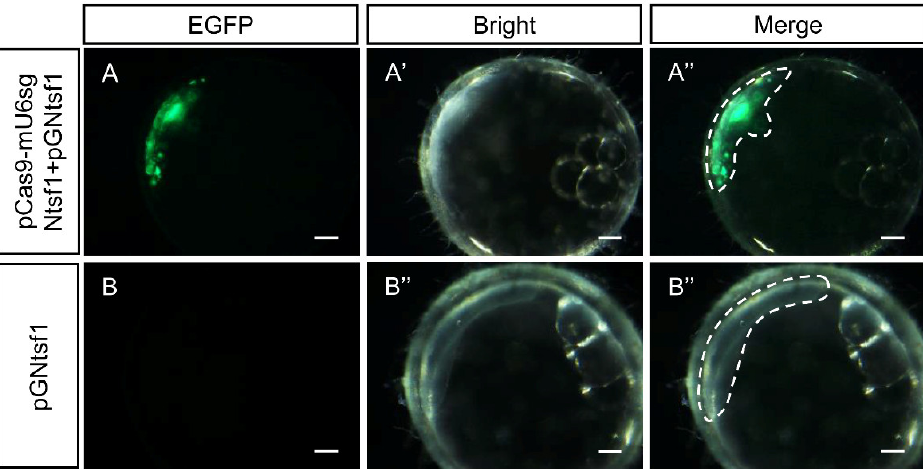
Figure 5. pCas9-mU6sgRNA mediated the exogenous and endogenous gene editing in medaka in vivo by one-cell embryo microinjection. ( A – B″ ) Microscopy images of medaka embryos injected with pCas9-mU6sgNtsf1 and the reporter vector pGNtsf1 ( A – A″ ) or injected with pGNtsf1 alone ( B – B″ ) 24 h after injection. Scale bars, 100 μm. ( C ) HMA of DNA templates extracted from embryos injected with pCas9-mU6sgptch1. Genomic DNA of each embryo was extracted separately. Boxed area indicates the heteroduplex or homoduplex DNA bands in amplicons from pCas9-mU6sgptch1 injected medaka embryos.